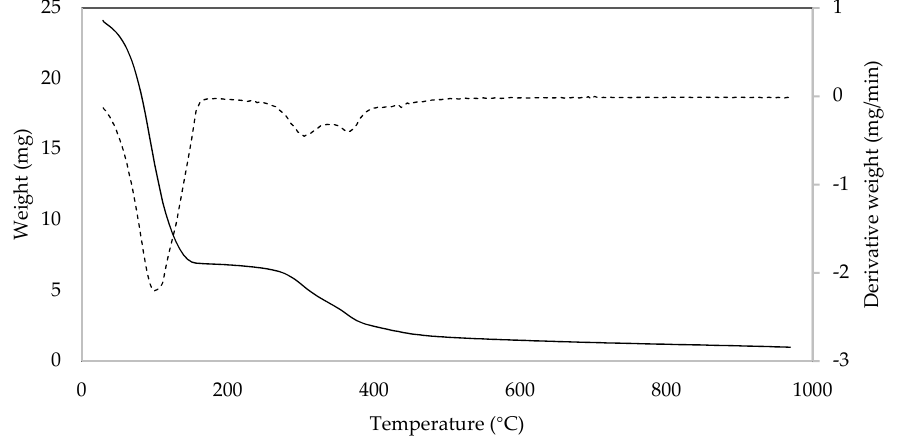
Figure 5. Thermogravimetric profile of brewers’ spent grains (the continuous line represents the TG curve while the dashed line represents the DT curve).